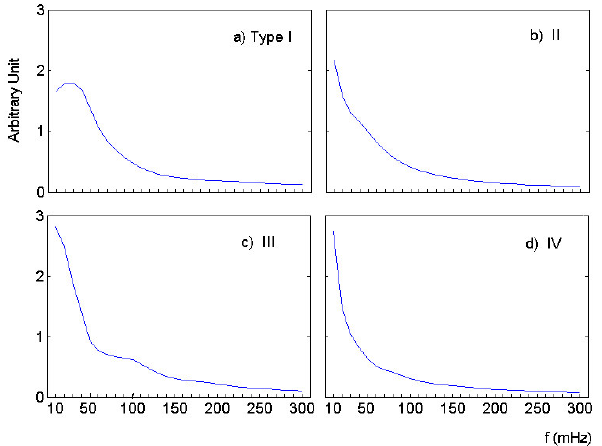
Fig. 8. Motion of patch of absorption in the IRIS FoV for spike event occurred in 1 November 1995, 18:30–19:30 UT (21:15– 22:15 MLT) at 18:48:00, 18:48:10, 18:48:20, and 18:48:30 UT is illustrated in panels 1, 2, 3, and 4, respectively. Numbers in brack- ets determine the location of narrow-beams (vertically and horizon- tally) in which maximum absorption occurred. Colorbars are in dB. Geographic directions are indicated in the top left corner of